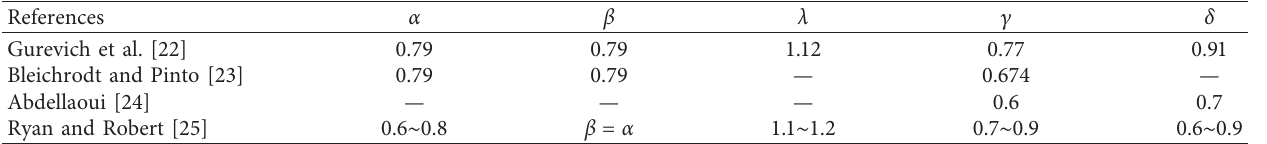
Table 2: Summary of parameters calibration results of stock